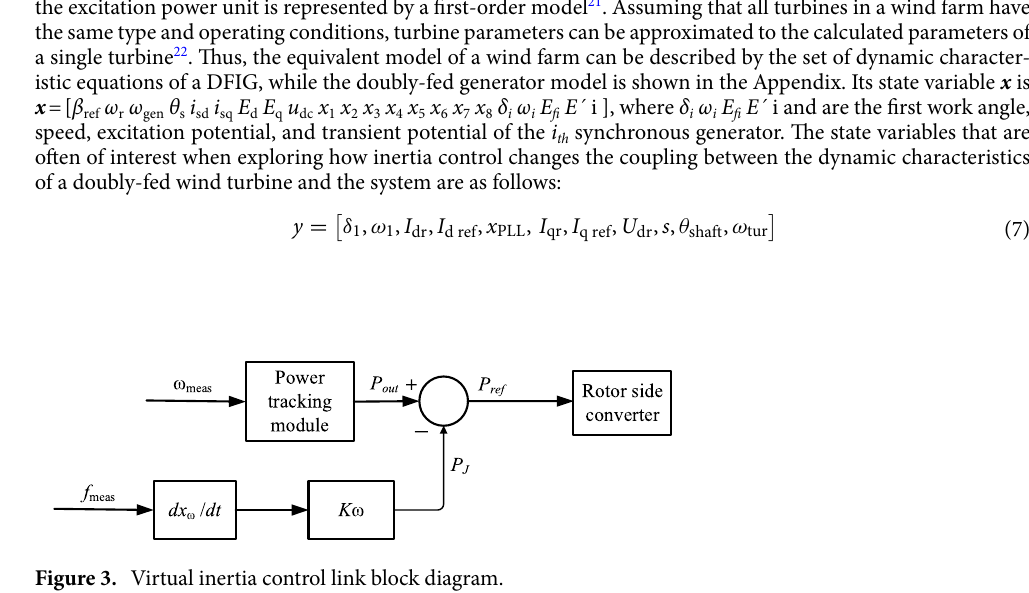
Figure 3. Virtual inertia control link block